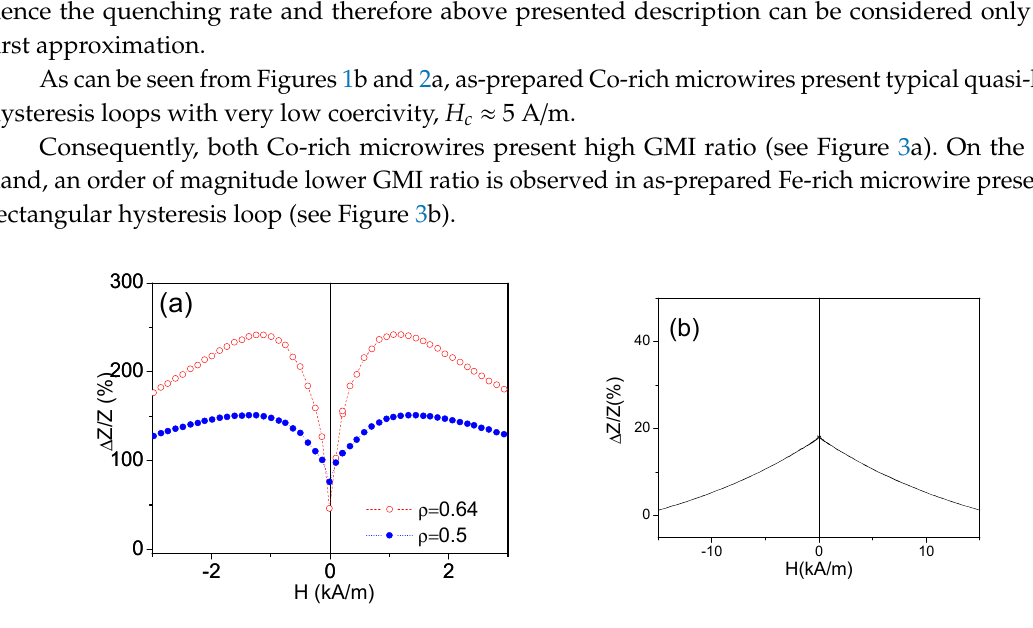
Figure 2. Hysteresis loops of as-prepared Co 67 Fe 3.85 Ni 1.45 B 11.5 Si 14.5 Mo 1.7 ( a ) and Fe 75 B 9 Si 12 C 4 ( b ) microwires with different ρ ratios.